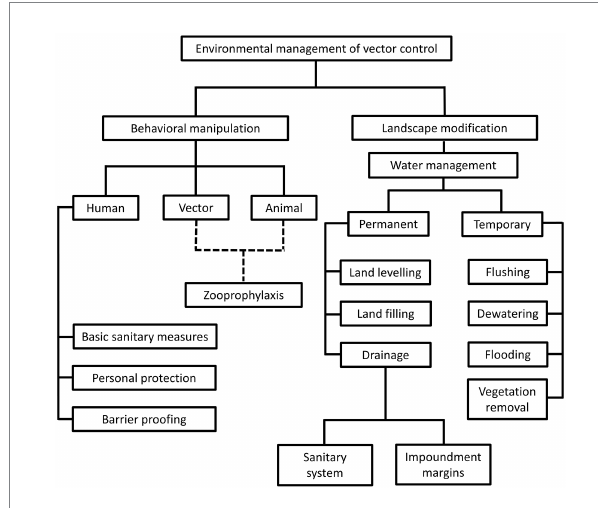
FIGURE 1 Different strategies under the environmental management of vector control. This approach revolves around behavioral alteration of humans, animals and vectors, as well as landscape modification, to create barriers between humans and vectors. Of note, the “zooprophylaxis” under “behavioral manipulation” involves the introduction of animals that are not pathogen reservoirs, to distract the blood-seeking vectors from humans and animals that serve as natural reservoirs of pathogens. This method involves behavioral alteration of animals and vectors, as indicated by the dotted lines in the diagram. On the other hand, landscape modification consists of permanent and temporary water management strategies to change the breeding environment of